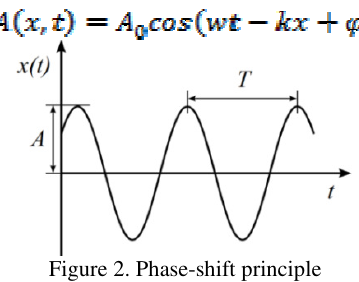
Figure 2. Phase-shift principle